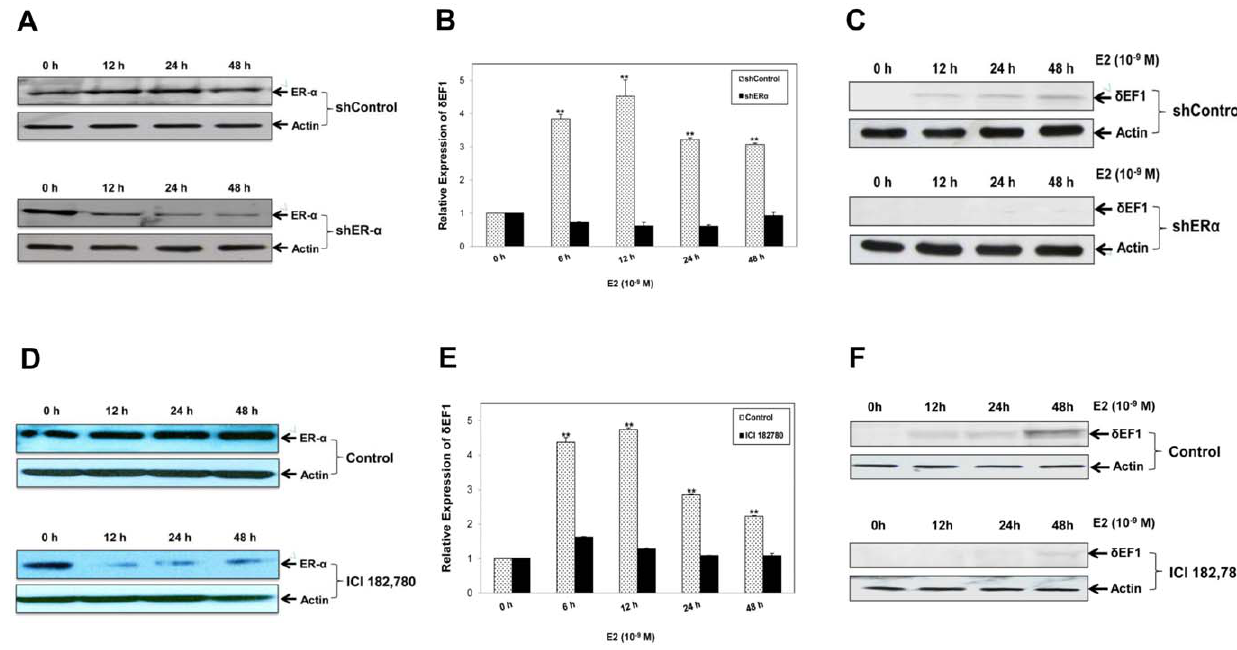
Figure 2. E2-induced up-regulation of d EF1 is ER- a -dependent. A. The ER- a -specific shRNA (shER- a ) was transiently transfected into MCF-7 cells. Control cells (shControl) were treated with the scrambled shRNA. At the indicated time points, the expression of ER- a protein was verified by Western Blot. Actin was used to normalize the ER- a level. B. shER- a or shControl was transiently transfected into MCF-7 cells followed by treatment with 10 2 9 M E2. The expression of d EF1 mRNA was determined at the indicated time points after treatment using Q-PCR. GAPDH was used to normalize the d EF1 level. ** indicates p , 0.01 in unpaired Student’s t-test compared with shControl. The data represent three independent experiments. C. shER- a or shControl was transiently transfected into MCF-7 cells followed by treatment with 10 2 9 M E2. The expression of d EF1 protein was determined at the indicated time points following treatment using Western Blot. Actin was used to normalize the d EF1 level. D. MCF-7 cells were pre-incubated with ICI 182,780 (1 m M) at the indicated time points. The expression of ER- a protein was verified by Western Blot. Actin was used to normalize the ER- a level. E. MCF-7 cells were pre-incubated with ICI 182,780 (1 m M) for 0.5 h followed by treatment with 10 2 9 M E2. The expression of d EF1 mRNA was determined at the indicated time points after treatment using Q-PCR. GAPDH was used to normalize the d EF1 level. ** indicates p , 0.01 in unpaired Student’s t-test compared with control. The data represent three independent experiments. F. MCF-7 cells were pre- incubated with ICI 182,780 (1 m M) for 0.5 h followed by treatment with 10 2 9 M E2. The expression of d EF1 protein was determined at the indicated time points following treatment using Western Blot. Actin was used to normalize the d EF1 level.